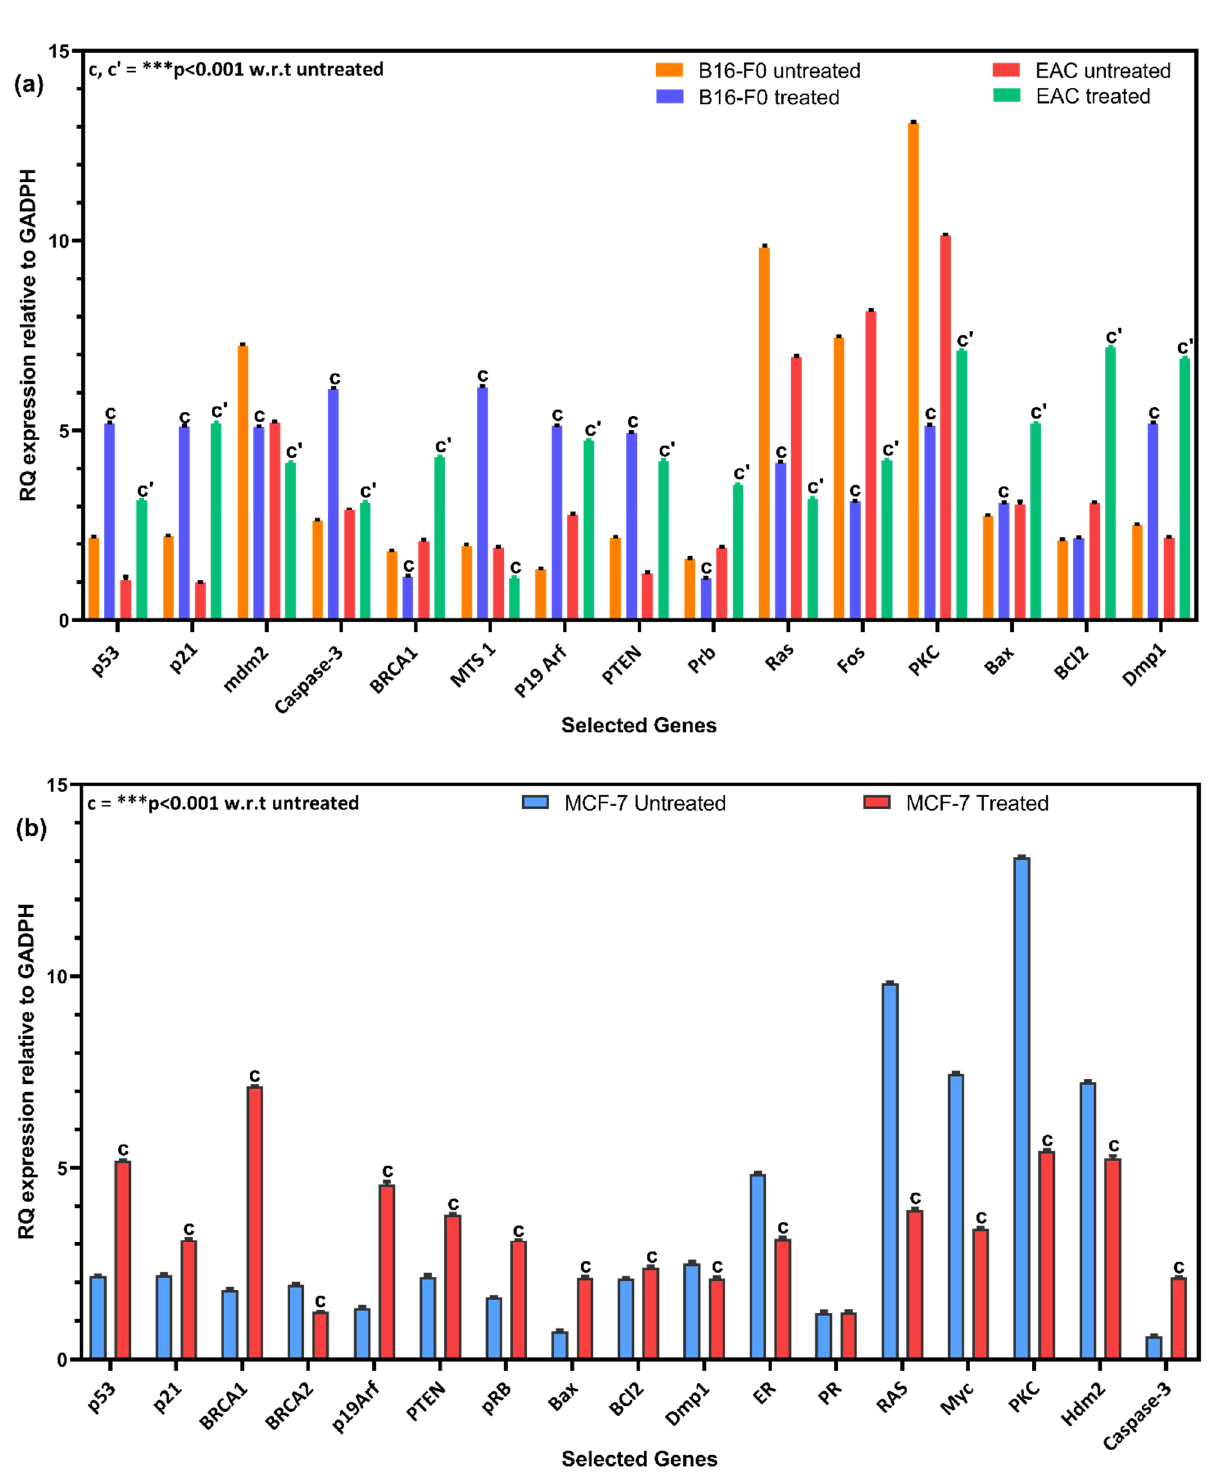
Figure 6. Selected gene expression after 3-MBTSc treatment ( a ) EAC and B16-F0 melanoma and ( b ) MCF-7 breast cancer. Similarly, 4-NBTSc treated cells, most tumor suppressor genes showed a significant upregulation. Notably, PTEN, BRCA1, and pRB are highly activated with 7.42, 5.13, and 4.19 folds in EAC, respectively (Figure 7 and Tables S7–S9). Likewise, PTEN, Dmp1, and Bax are upregulated with 4.82, 4.7 and 3.35 folds in B16-F0 melanoma. Also, in MCF-7 breast cancer cell lines, PTEN, pRB, and BRCA2 are upregulated with 2.95, 2.21, and 2.195 folds, respectively. In comparison, the expressions of oncogenes are significantly down-